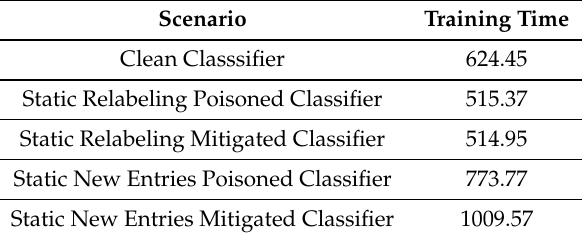
Table 7. Summary of Training Time (Seconds) for Proposed Static Adversarial Scenarios.